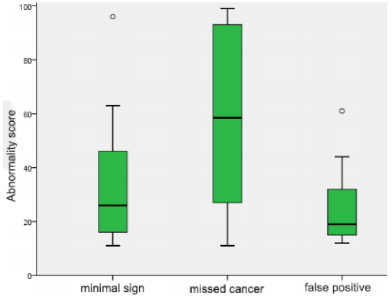
Figure 4. Comparison of abnormality scores in prior mammograms. Box and whiskers plot showing the distribution of abnormality scores of minimal signs, missed cancer and false positive cases. All box plots proved the median value (solid line), interquartile range (green box), 95% confidence interval (black whiskers) and outliers beyond the 95% confidence interval (blank